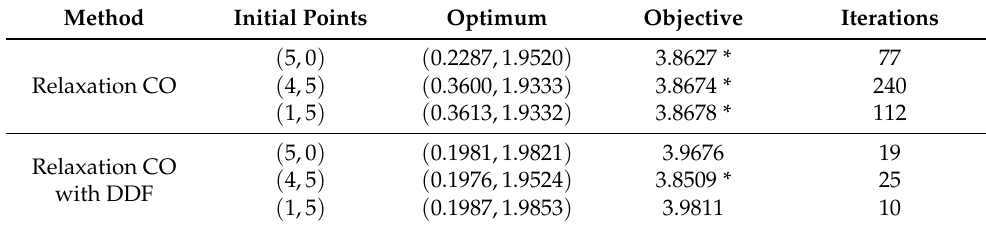
Figure 7. Numerical test iteration path ( a ) Relaxation CO method; ( b ) Relaxation CO method with DDF. Table 2. Comparison of optimization results at different initial